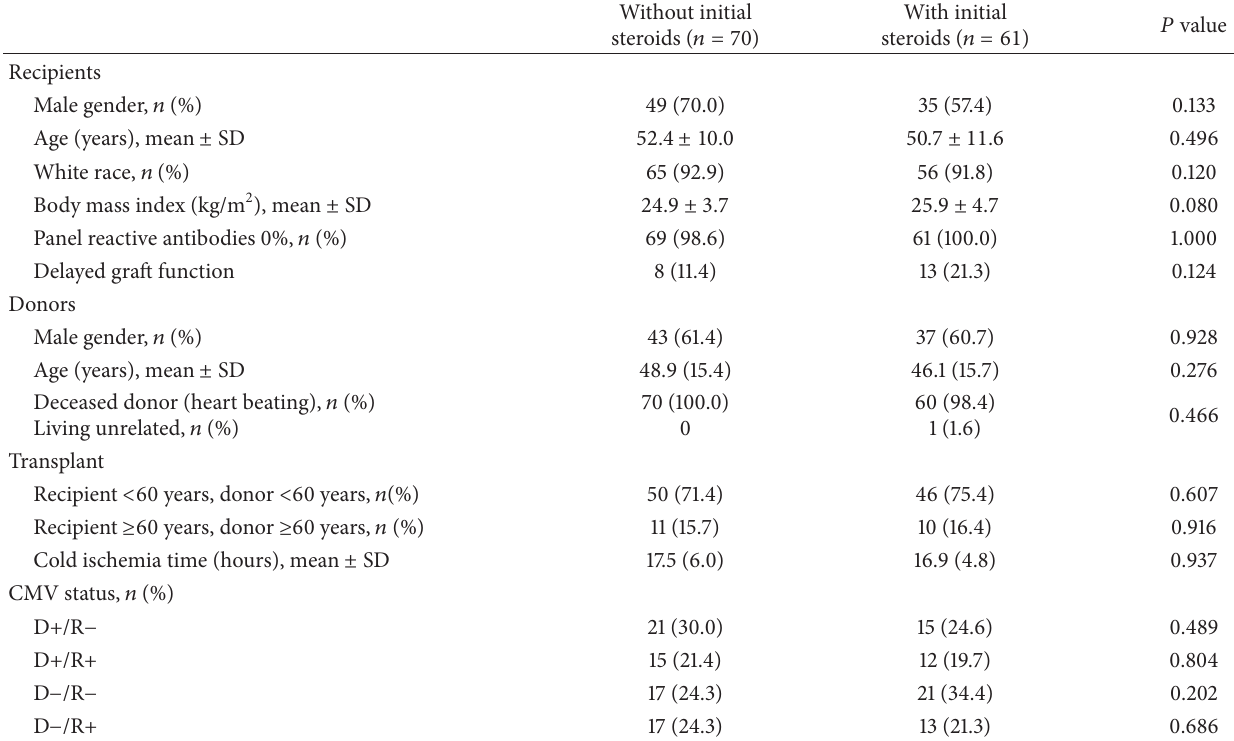
Table 1: Demographics and baseline